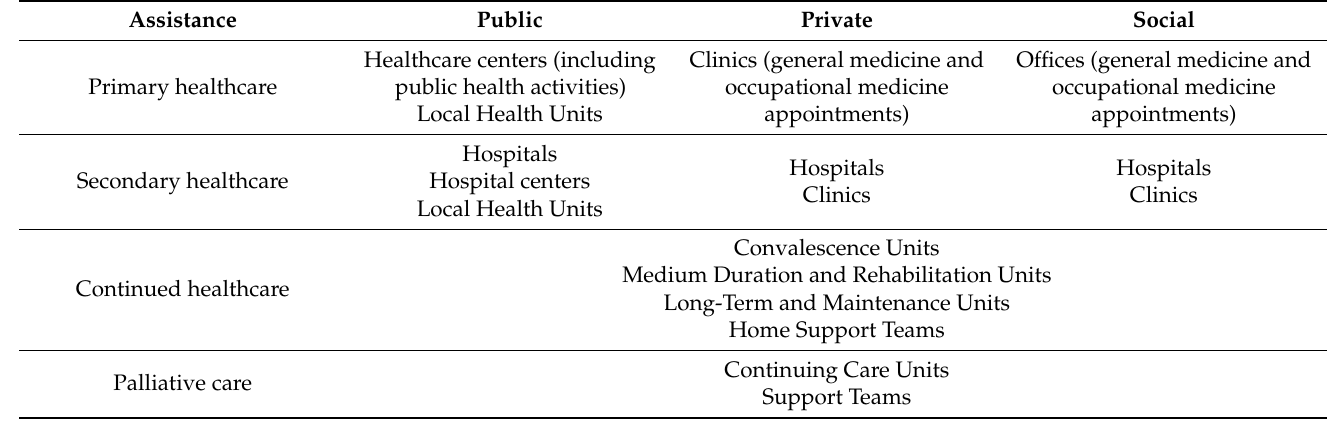
Table 1. Sources of healthcare assistance in Portugal